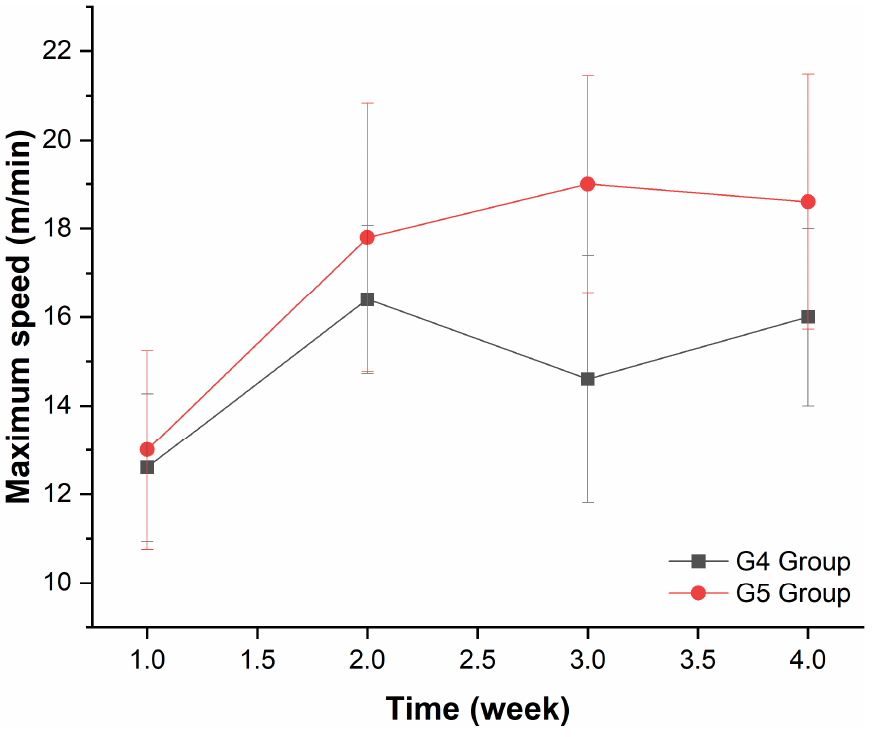
Figure 4. Maximum speed evolution during four weeks of treadmill training in the G4 and G5 groups. Table 5. ANOVA test of the maximum speed evaluated during the course of four weeks of treadmill training in the G4 and G5 groups.